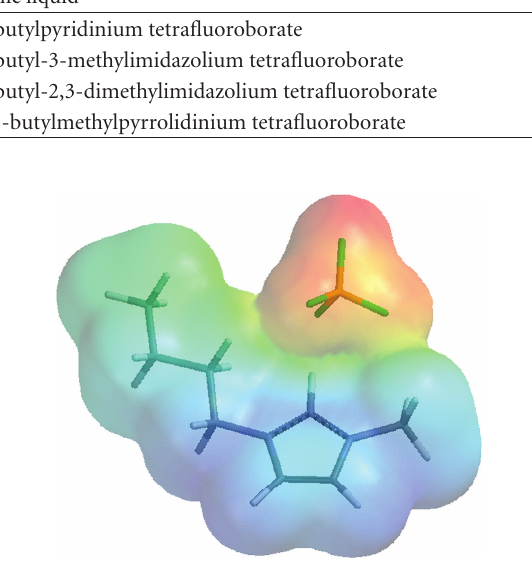
Figure 1: Structure of [bmim + ][BF 4 − ] showing the electrostatic potential projected on the van der Waals surface (surface = electron density of 0.002 e/au 3 , property = electrostatic potential). The elec- tron density is high under the red positions and low under the blue positions, indicative for negative and positive parts of the molecular ensemble.